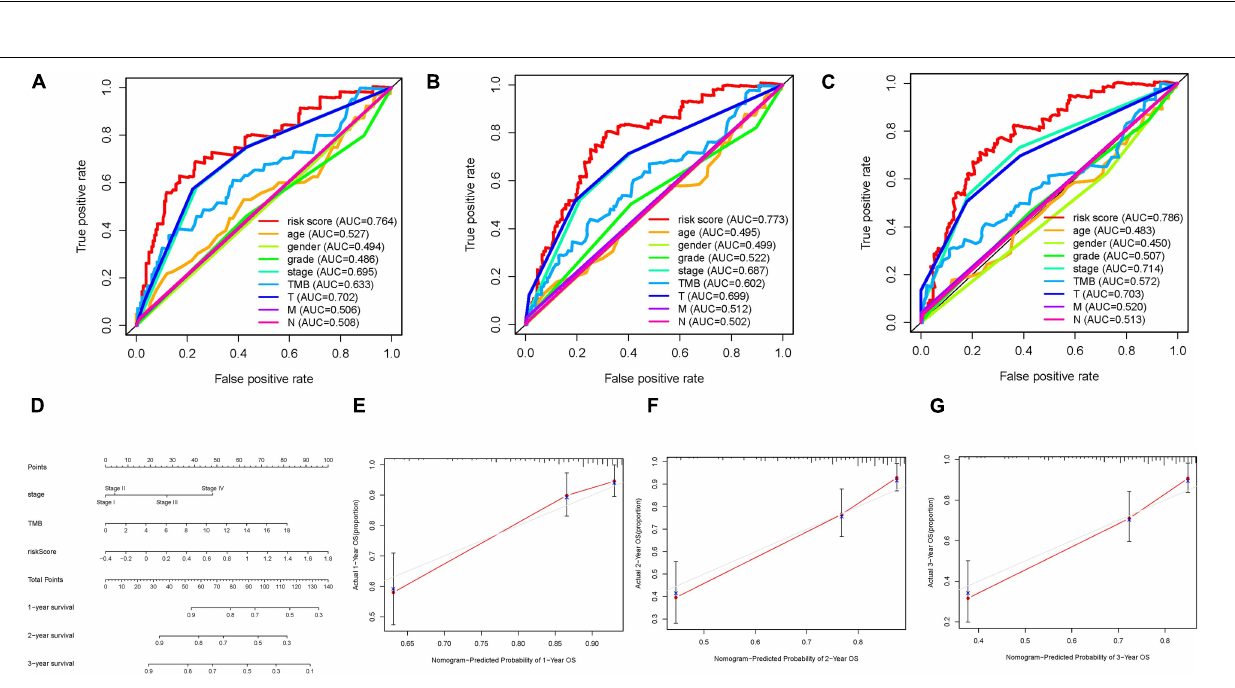
Frontiers in Cell and Developmental Biology |